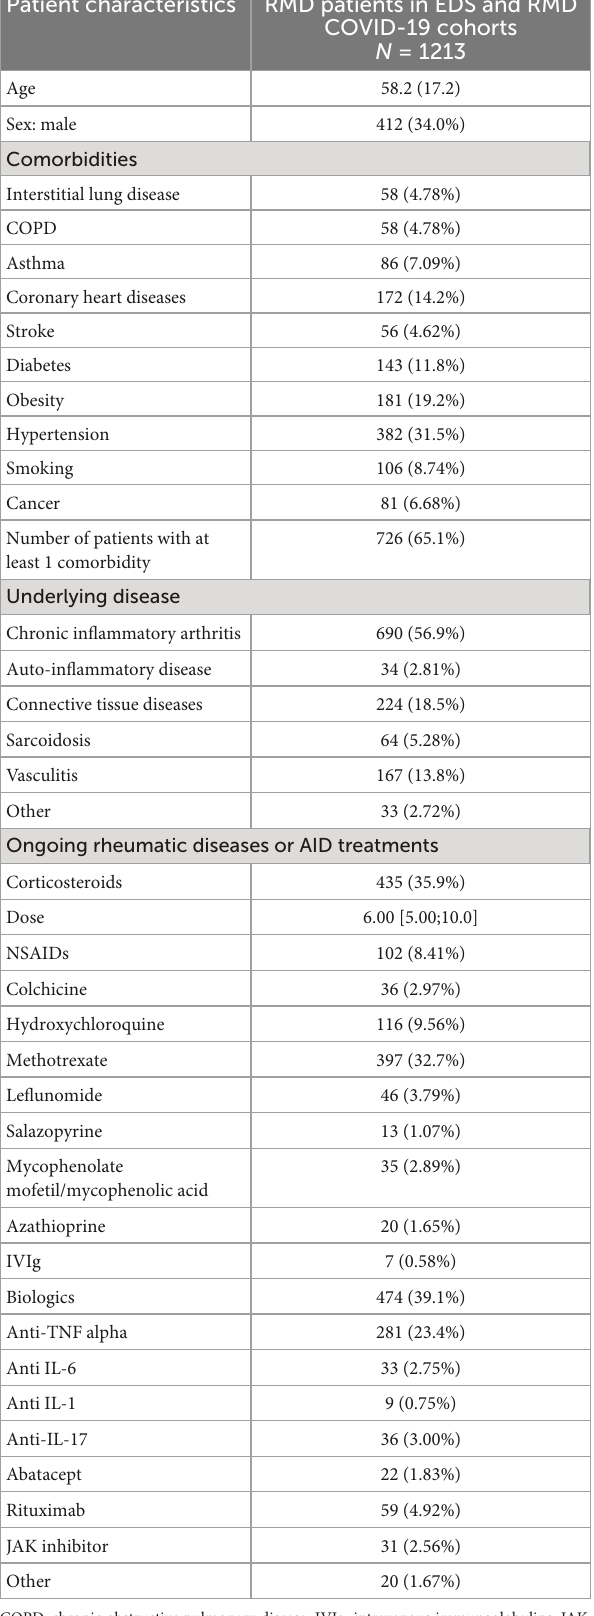
TABLE 1 Characteristics of RMD patients in the pooled analysis of EDS and RMD COVID-19 French cohorts ( N = 1213). Patient